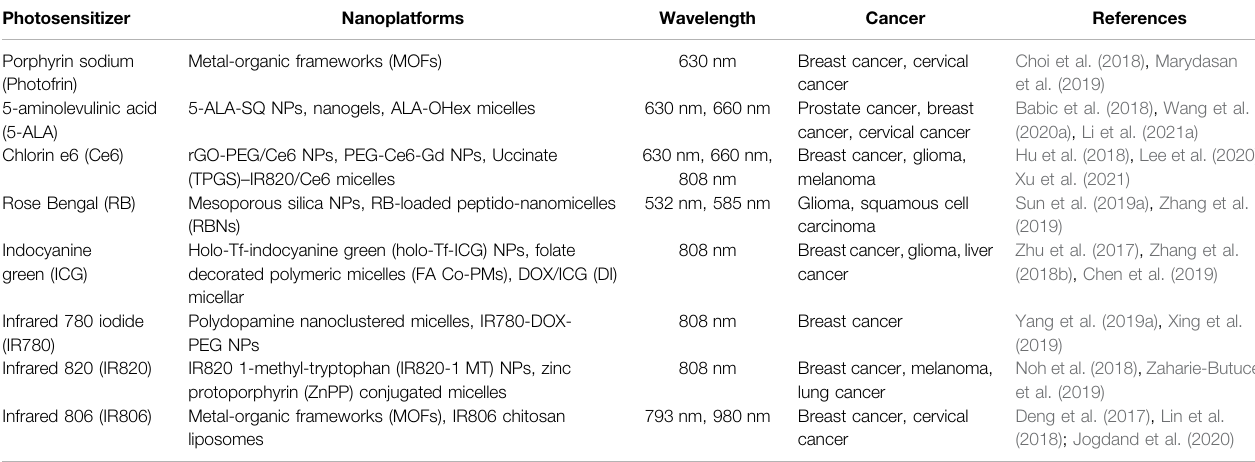
TABLE 1 | Summary of nanocomposites containing photosensitizers for cancer therapy.